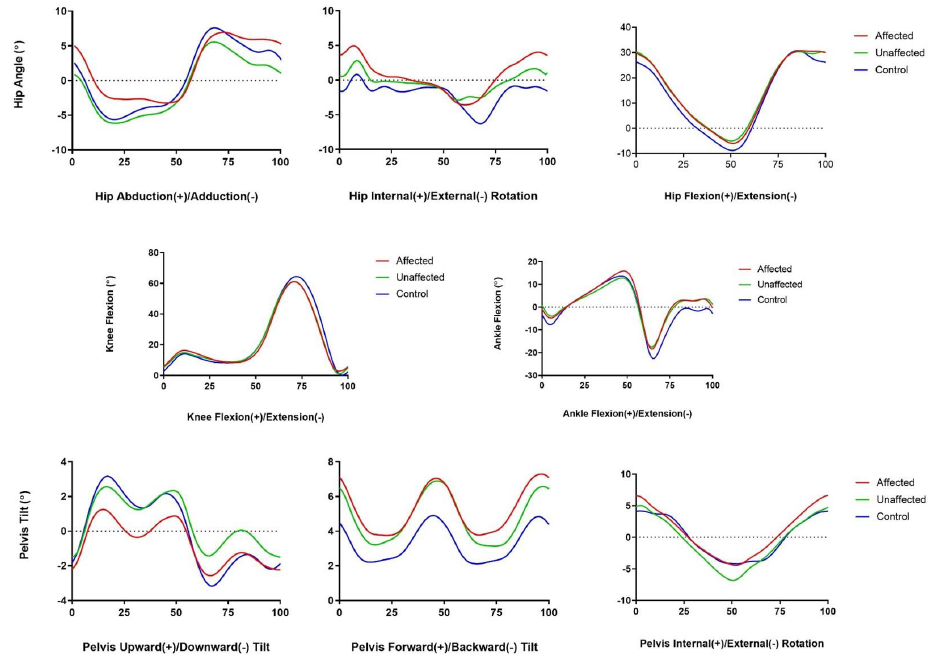
Figure 3. Meanrangeofmotionofthehip, pelvis, andkneethroughoutthegaitcycleamongtheparticipants. Figure 3. Mean range of motion of the hip, pelvis, and knee throughout the gait cycle among the participants. Table 2. Deviation in terms of temporal parameters between affected limbs of patients with DDH For temporal parameters, there was a significant increase in swing phase duration, compared with control and unaffected swing phase per gait cycle, single support phase duration, single support phase per gait cycle, midstance duration, and midstance per gait cycle in the DDH group compared with in the control (Table 2). Simultaneously, significant reductions in stance phase per gait cycle, double support phase duration, double support phase per gait cycle, loading response